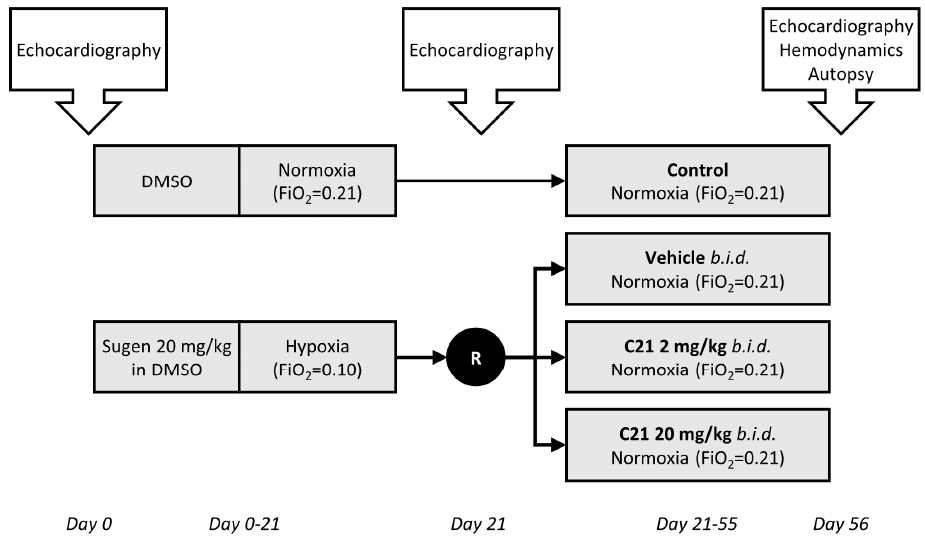
Figure 5. Overview of the study design. Animals received a single subcutaneous injection of Sugen (20 mg/kg) in 2 mL 100% DMSO and were kept under hypoxic conditions for 21 days (SuHx groups). On day 21, an echocardiogram was performed carried out to achieve an even distribution of the disease in the three study groups. The animals were exposed to ambient oxygen levels from day 22 to day 56. From day 21 to day 55, C21 (2 mg/kg or 20 mg/kg) or vehicle was administered twice a day by gavage. Control group animals received a single subcutaneous injection of 2 mL 100% DMSO on day 0 and were exposed to ambient oxygen for the total study period.